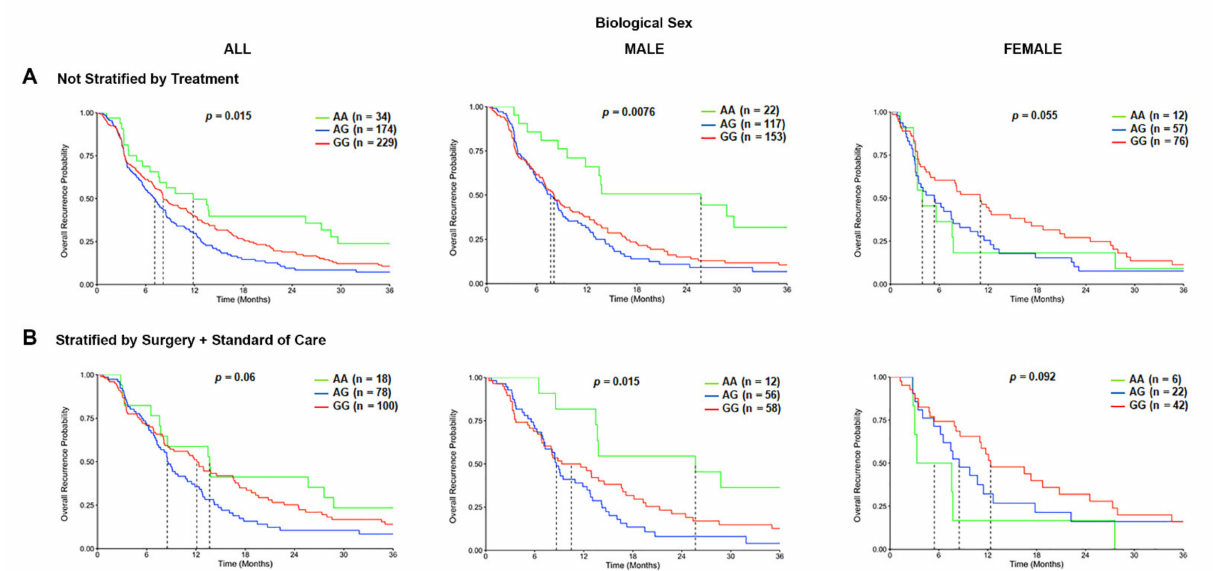
Figure 4. Progression-free survival (PFS) curves in the carriers of TSPO rs6971 polymorphism stratified by genotype, biological sex, and treatment, using the CCF cohort. ( A ) Overall recurrence probability curves in the entire population ( left panel ), male subgroup ( middle panel ), and female subgroup ( right panel ) comparing the wild-type A/A, heterozygous A/G, and variant G/G genotypes for the TSPO rs6971 polymorphism using patient data from the CCF cohort. ( B ) Overall recurrence probability curves stratifying by treatment (those who underwent surgical resection followed by standard of care treatment) in the entire population ( left panel ), the male subgroup ( middle panel ), and the female subgroup ( right panel ) comparing the wild-type A/A, heterozygous A/G, and variant G/G genotypes for the TSPO rs6971 polymorphism. Genotype patient numbers and p -values are indicated in each graph, and the median and statistical data are in Table